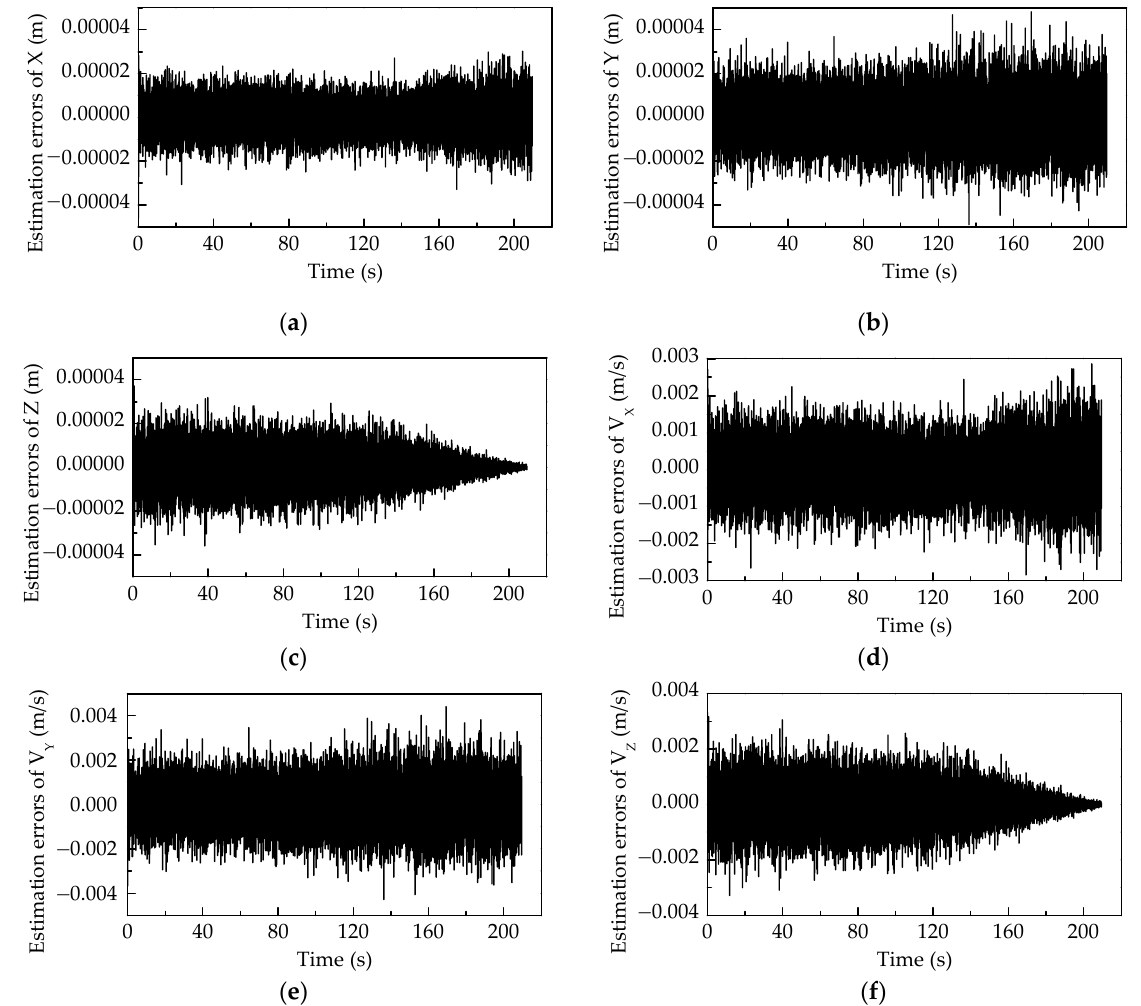
Figure 7. The estimation errors of the relative state: ( a ) X, ( b ) Y, ( c ) Z, ( d ) V X , ( e ) V Y , and ( f ) V Z . Figure 8 shows the average relative distance of 100 Monte Carlo runs between the players in three scenarios: the pursuer plays without time delay, without compensation for time delay, and with compensation for time delay. When the pursuer plays without time delay, the average interception time is 209.56 s. The average terminal distance between the two players is 0.9013 m, which is less than the safe distance. When the pursuer plays without compensation for time delay, the average relative distance between the two players reaches the minimum value of 19.1841 m at 206.89 s. After that, the relative distance increases. The reason is that after a period of acceleration, the velocity has reached a relatively large value. After the two players miss each other, it takes a while for the velocity to change. However, the distance between the players still increases, which means the pursuer cannot intercept the evader in a short time. When the pursuer plays with compensation for time delay, the average interception time is 211.69 s. The average terminal distance between the two spacecraft is 0.9763 m, which is less than the safe distance. By comparison, we can see that with compensation for time delay, the pursuer can significantly reduce the relative distance between the pursuer and the evader. Although the interception time is longer than that in the no time delay scenario, it still intercepts the evader successfully.